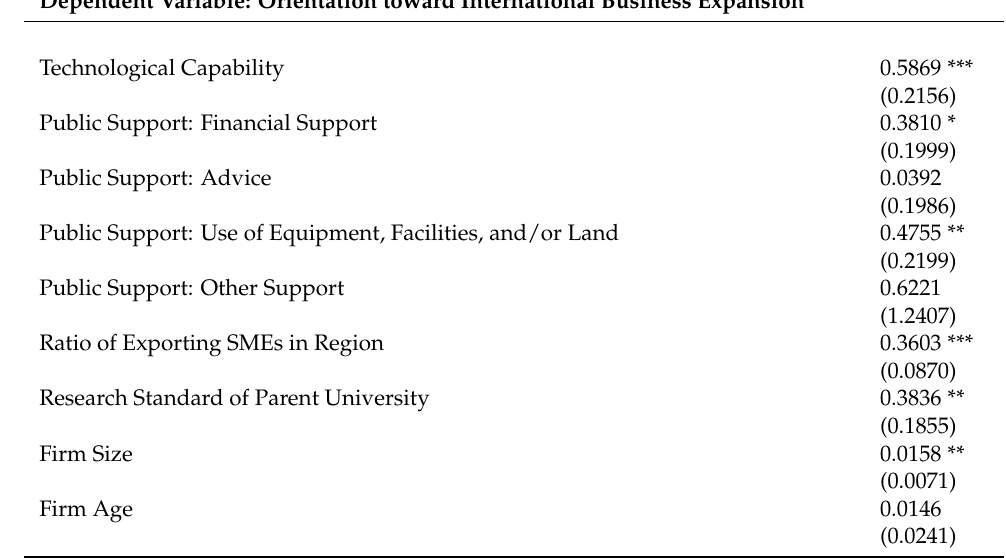
Table 4. Determinants of orientation toward international business expansion: types of public